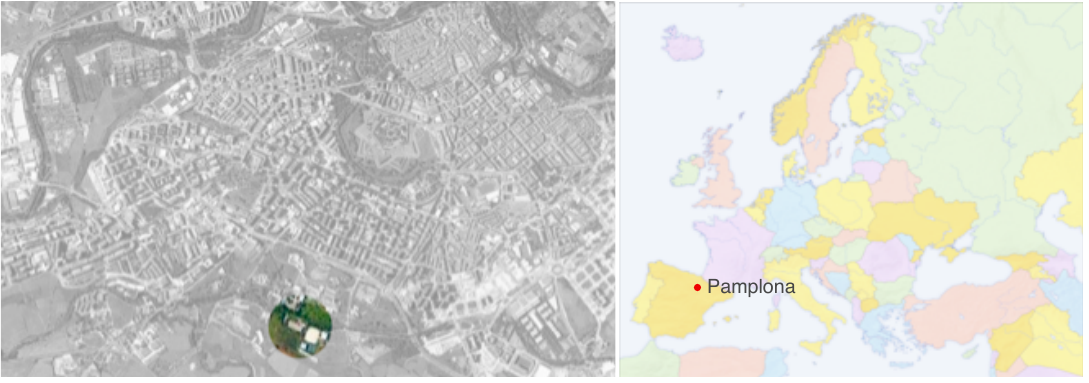
Figure 8. Location of the building of School of Architecture of the University of